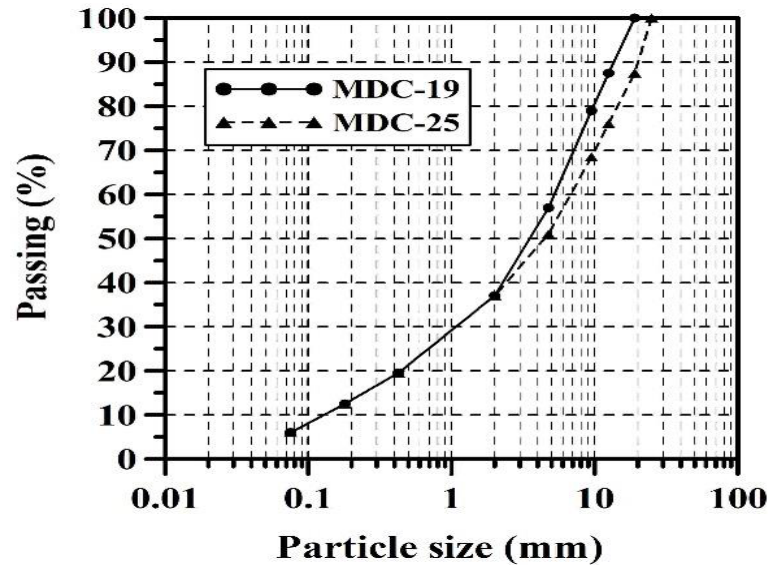
Figure 2. Gradation of the MDC-19 and MDC-25 mixes.